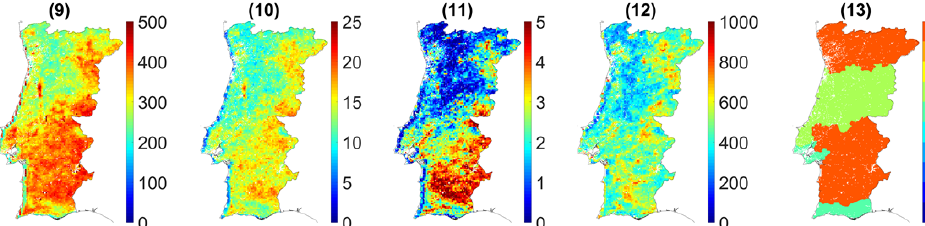
Figure 2. As in Fig. 1, but with respect to sensitivity component.